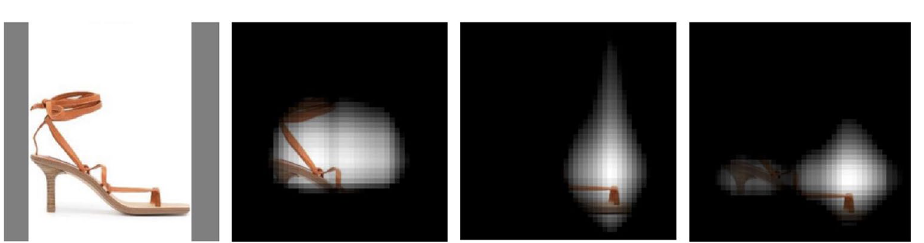
Figure 8. Grounding and compositionality. Localization maps for a product retrieved with the query “ankle strap sandals with high heels”: left-to-right, the product, “ankle strap”, “sandals”, “high